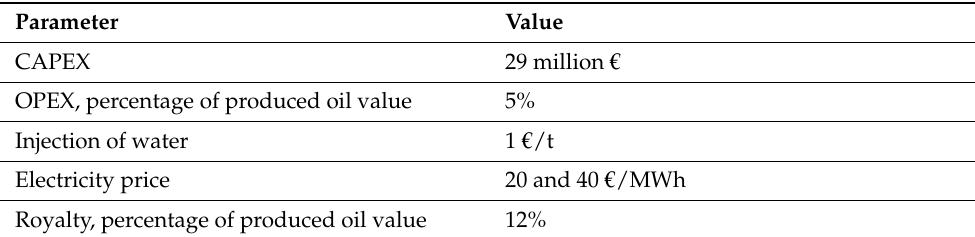
Table 5. Input values for costs of development and implementation of